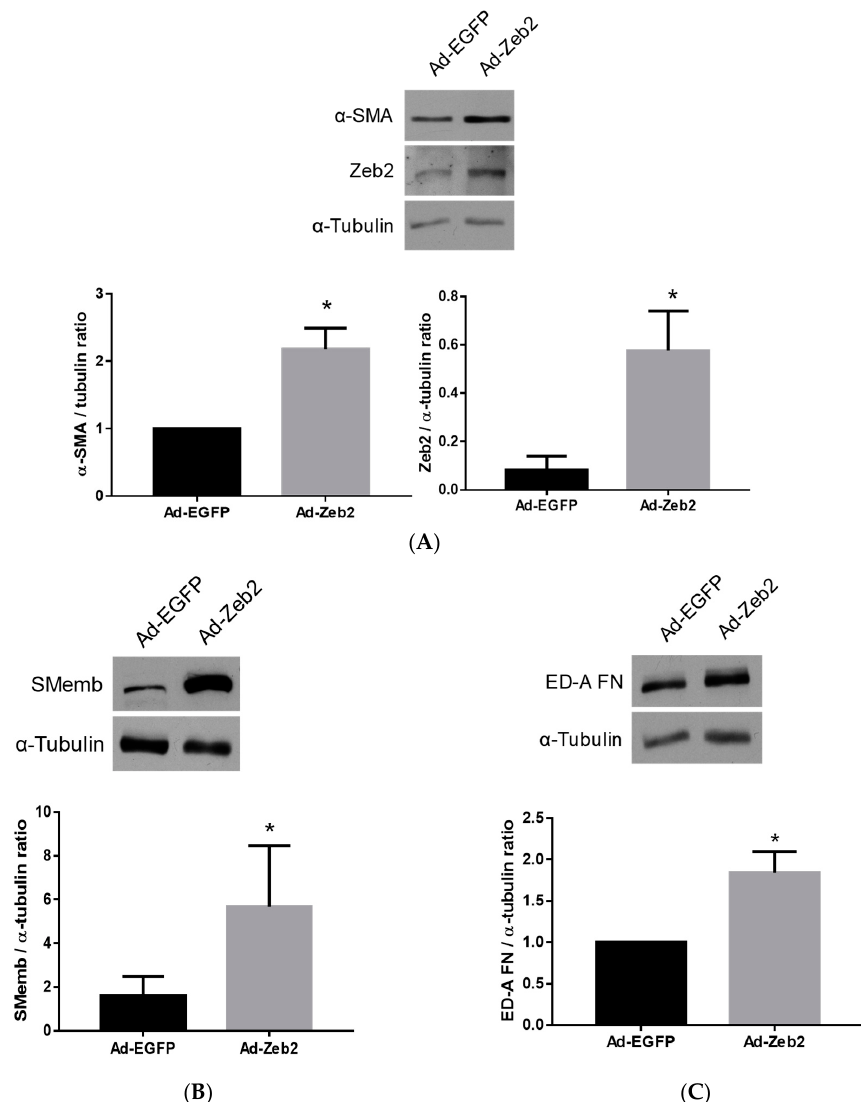
Figure 2. Zeb2 overexpression induces expression of proteins characteristic of the myofibroblast phenotype in primary rat cardiac fibroblasts. P1 cells were transduced with Ad-EGFP or Ad-HA-Zeb2 and incubated for 96 h prior to Western blot analysis. α -Tubulin was used as a loading control. Rabbit polyclonal anti-Zeb2 antibody was used to determine Zeb2 expression levels (Panel A). Ectopic expression of Zeb2 increased the expression of ( A ) α -SMA, ( B ) SMEmb and ( C ) ED-A fibronectin. Right panels are histographic representations of respective expression of markers relative to α -tubulin. The data shown are from n = 4 independent experiments for α -SMA and SMemb, and n = 3 for ED-A fibronectin. * p < 0.05 vs. Ad-EGFP. Error bars represent SEM. Data were analyzed by performing Student’s t -tests.